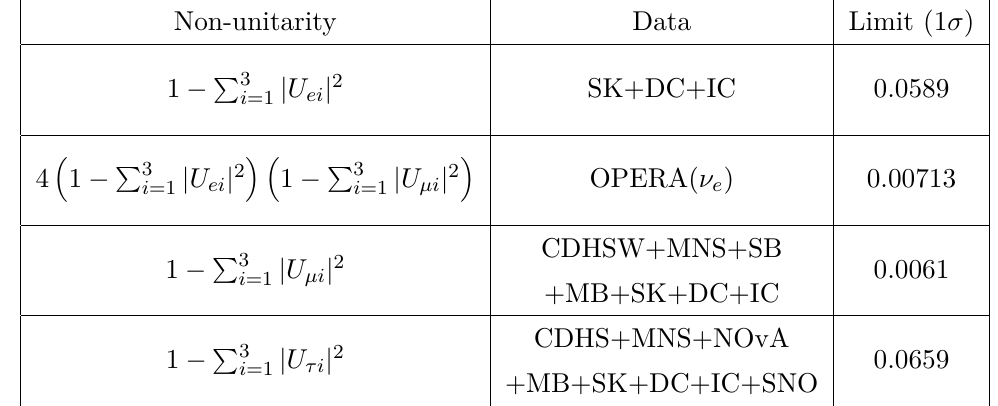
Table 4 . Limits on sterile neutrino mixing from global fits. Searches for sterile neutrinos with null results 5 are used. Exclusion limits at ∆ m 2